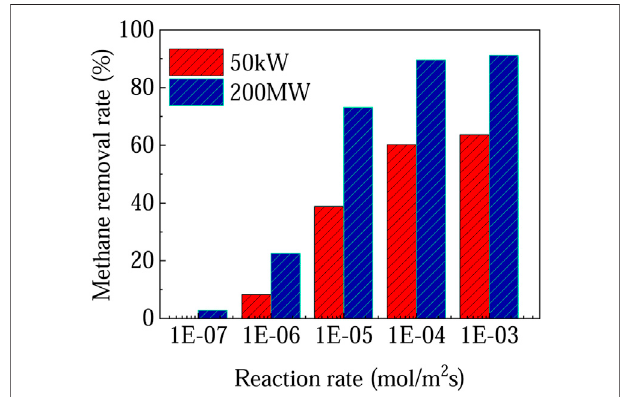
FIGURE 5 | Methane removal rate at different reaction rates.